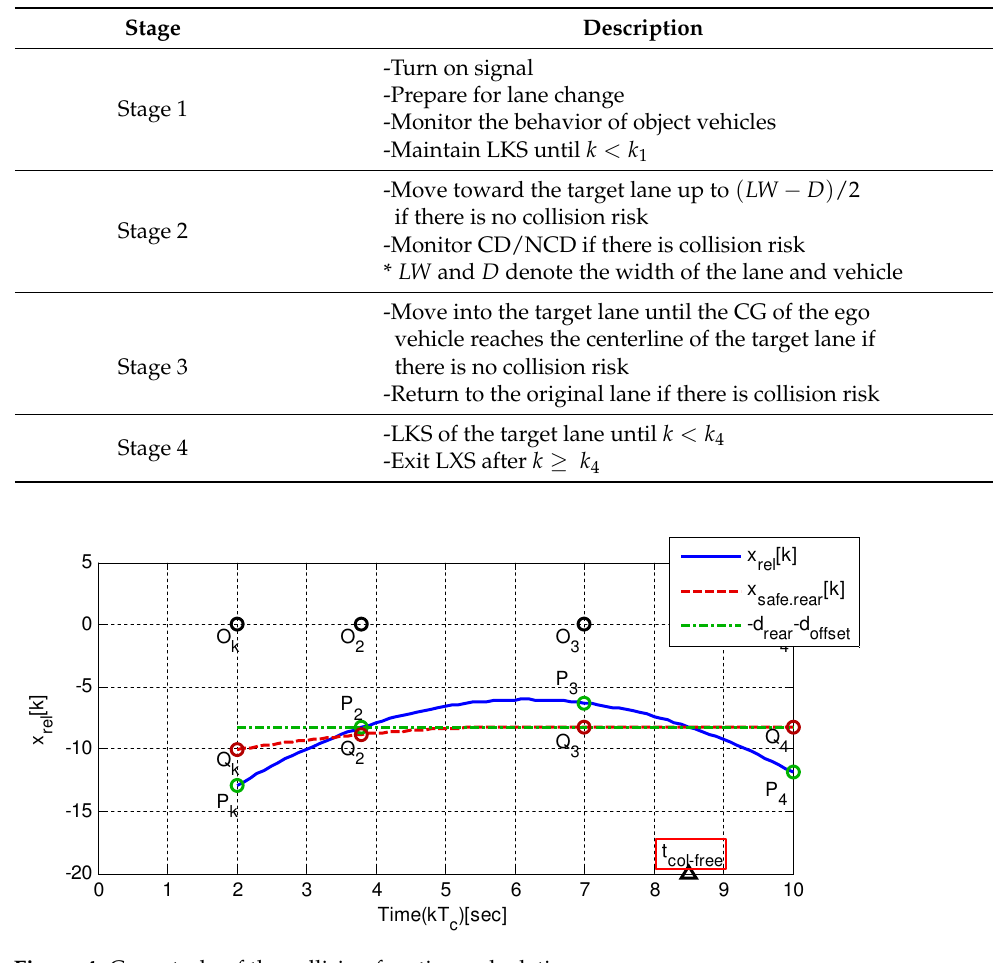
Figure 4. Case study of the collision free time